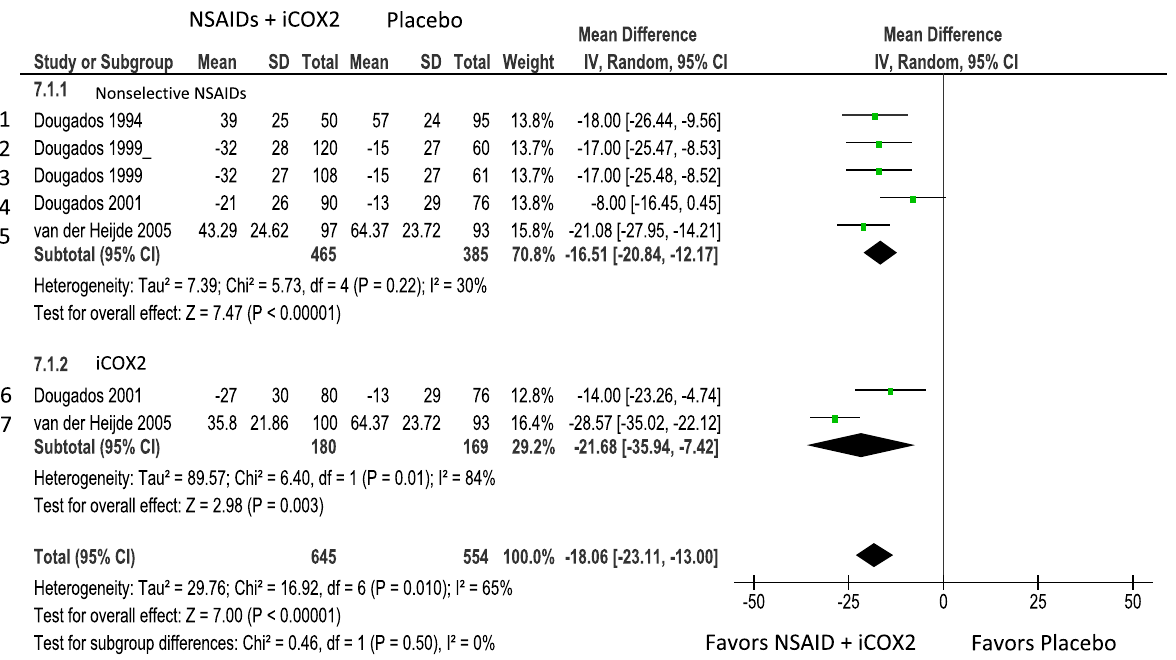
Fig. 2 Spinal pain by visual analogue scale (VAS 0 – 100 mm): analysis of subgroups of four randomized clinical trials of patients with ankylosing spondylitis ( n =1199). Meta-analyses comparing traditional NSAIDs versus placebo, selective COX-2 inhibitors versus placebo, and both NSAID subtypes versus placebo. Subtitle: (1) Ximoprofen 30 mg vs placebo. (2) Meloxicam 15 mg vs placebo. (3) Piroxicam 20 mg vs placebo. (4) Ketoprofen 200 mg vs placebo. (5) Naproxen 1000 mg vs placebo. (6) Celecoxib 200 mg vs placebo. (7) Etoricoxib 90 mg vs